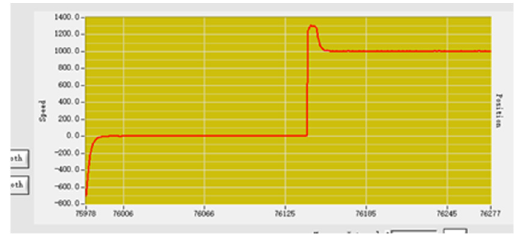
Figure 16. Proportional adjustment speed curve.